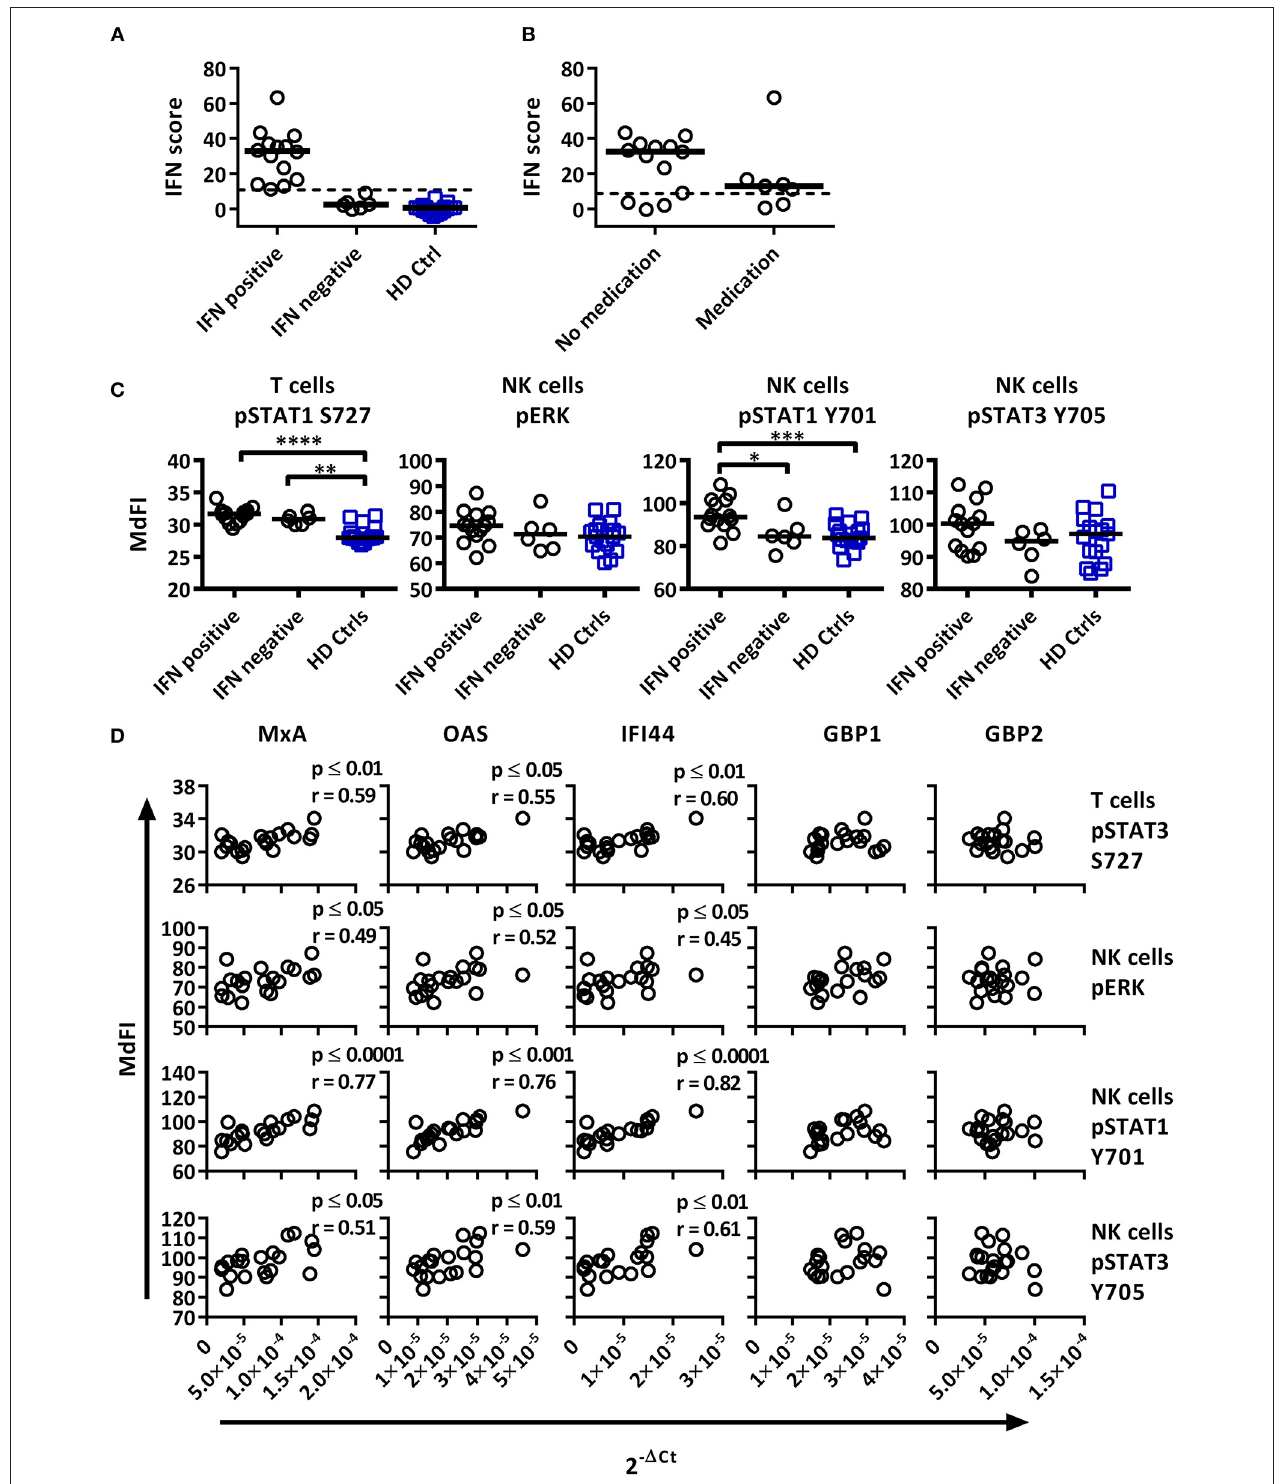
FIGURE 4 | Associations of the basal phosphorylation profile with type I IFN inducible gene expression in pSS patients and healthy controls. IFN score was calculated based on standardized expression levels of three type I IFN inducible genes (MxA, OAS1, IFI44). A threshold was set to 8.8 based on 3 × SD of healthy controls as seen in (A) . Association between IFN score and the use of DMARD or corticosteroids is seen in (B) . Unpaired Mann-Whitney test comparisons